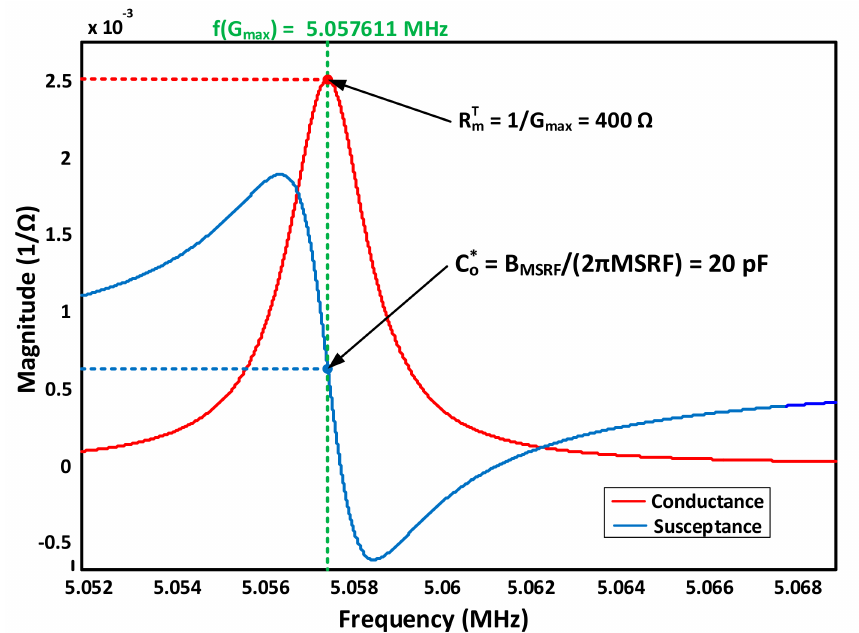
Figure 7. Impedance analyzers characterization principle in measuring BVD parameters for a typical 5 MHz